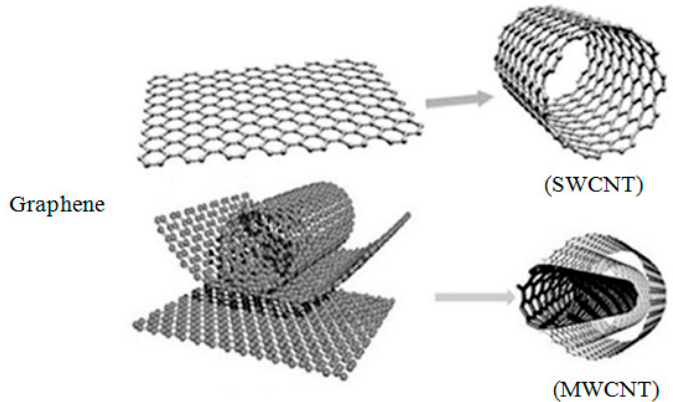
Figure 2. Graphene, single walled carbon nanotubes (SWCNT) and multiwall carbon nanotubes (MWCNT) structures [88].